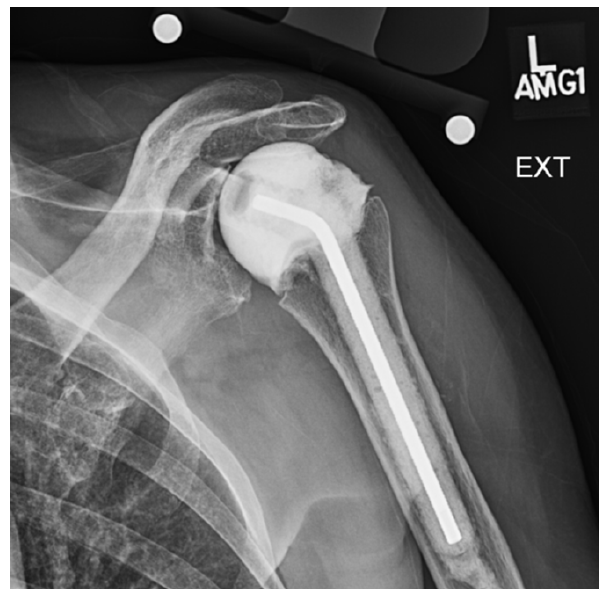
Figure 3. X-ray of the left shoulder with placement of an antibiotic- impregnated articulating spacer for the treatment of glenohumeral septic arthritis secondary to extending scapular osteomyelitis.